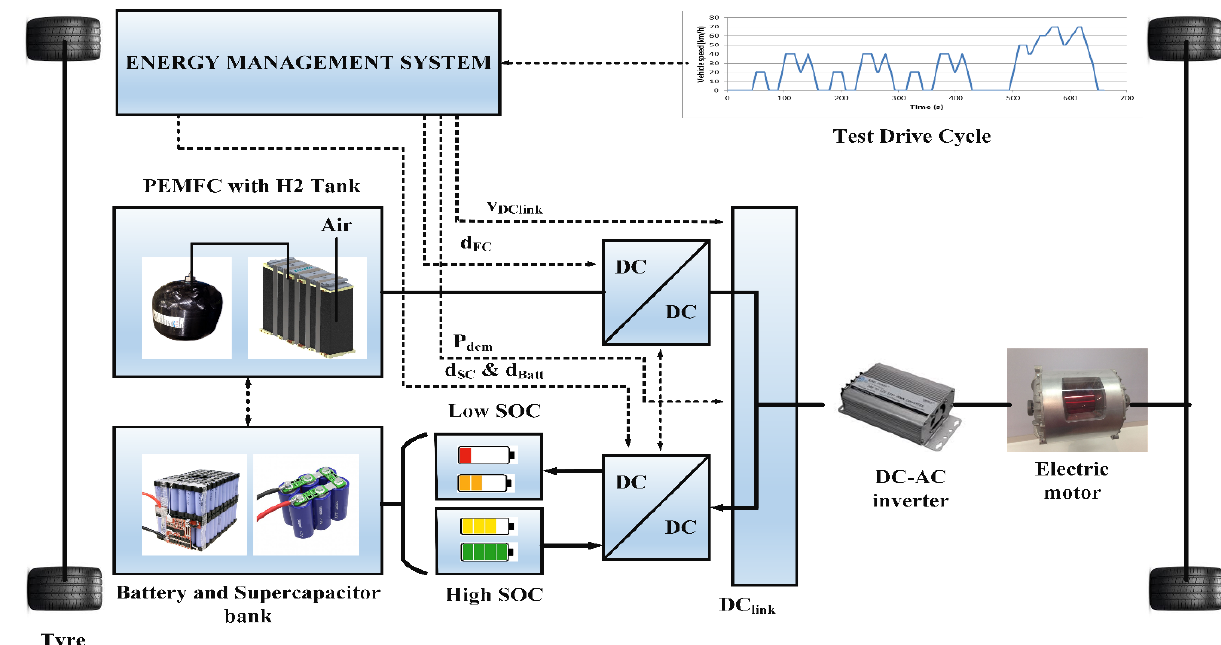
Figure 1. Configuration of energy management in a hybrid electric vehicle.